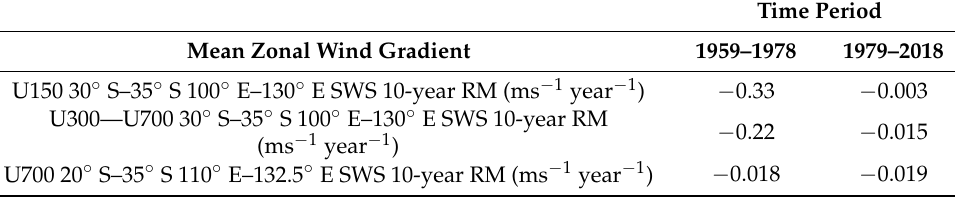
Table 5. The average gradients or trends of SWS 150 hPa zonal wind averaged between 30 ◦ S and 35 ◦ S, 100 ◦ E and 130 ◦ E, 300 hPa minus 700 hPa zonal wind shear averaged between 30 ◦ S and 35 ◦ S, 100 ◦ E and 130 ◦ E and 700 hPa zonal wind averaged between 20 ◦ S and 35 ◦ S, 110 ◦ E and 132.5 ◦ E, for different time